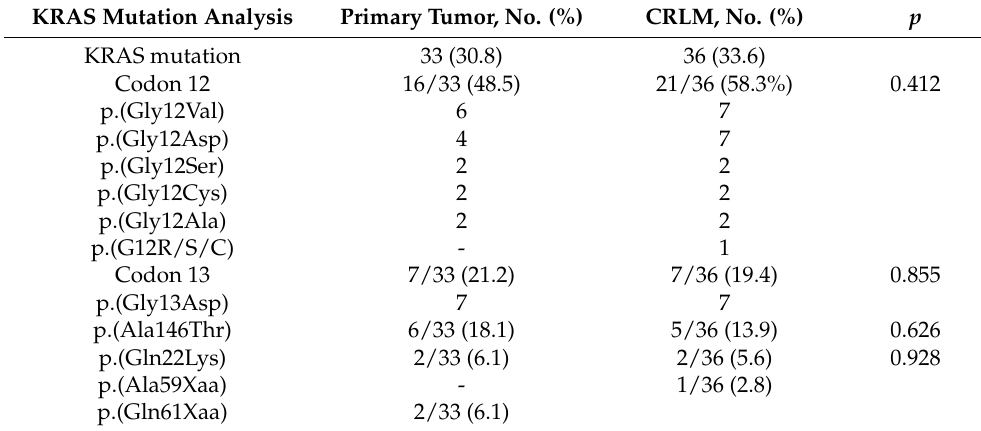
Table 2. Distribution of KRAS mutation type in primary colorectal tumor and in